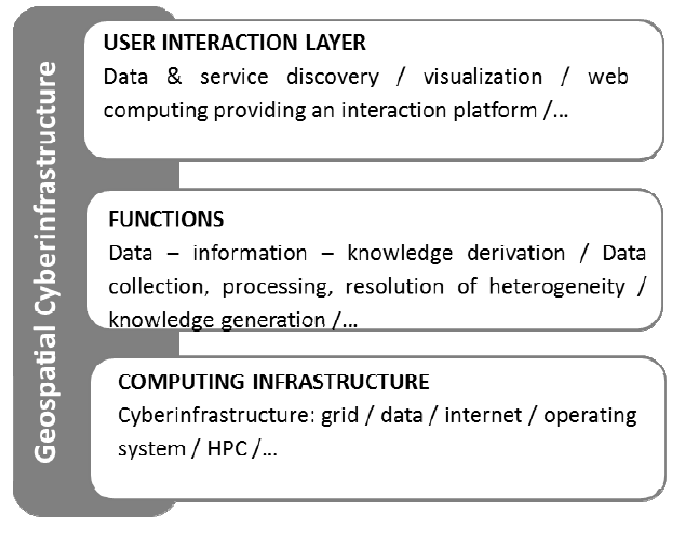
Figure 3. The main components of geospatial cyberinfrastructure after Yang et al .